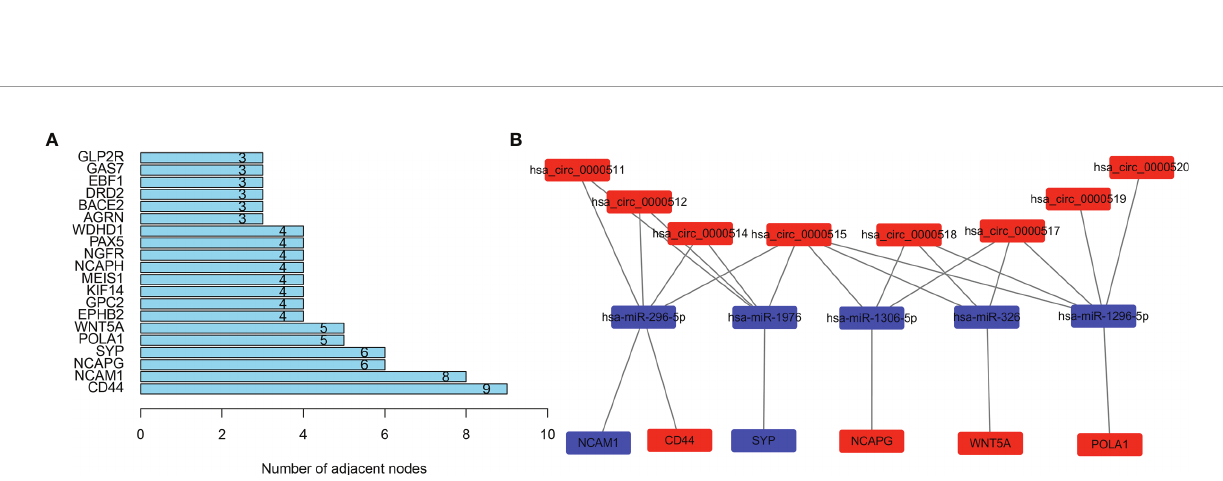
FIGURE 5 | Selecting hub genes and constructing circular RNA (circRNA) – miRNA – hub gene subnetwork. (A) Selecting hub genes: WNT5A, POLA1, SYP, NCAPG, NCAM1, and CD44 by analysing the protein – protein interaction (PPI) network. Adjacent differential gene interaction nodes are ≥ 5. (B) Reconstructing a circRNA – miRNA – hub gene subnetwork based on the circRNA – miRNA – mRNA network and hub genes.